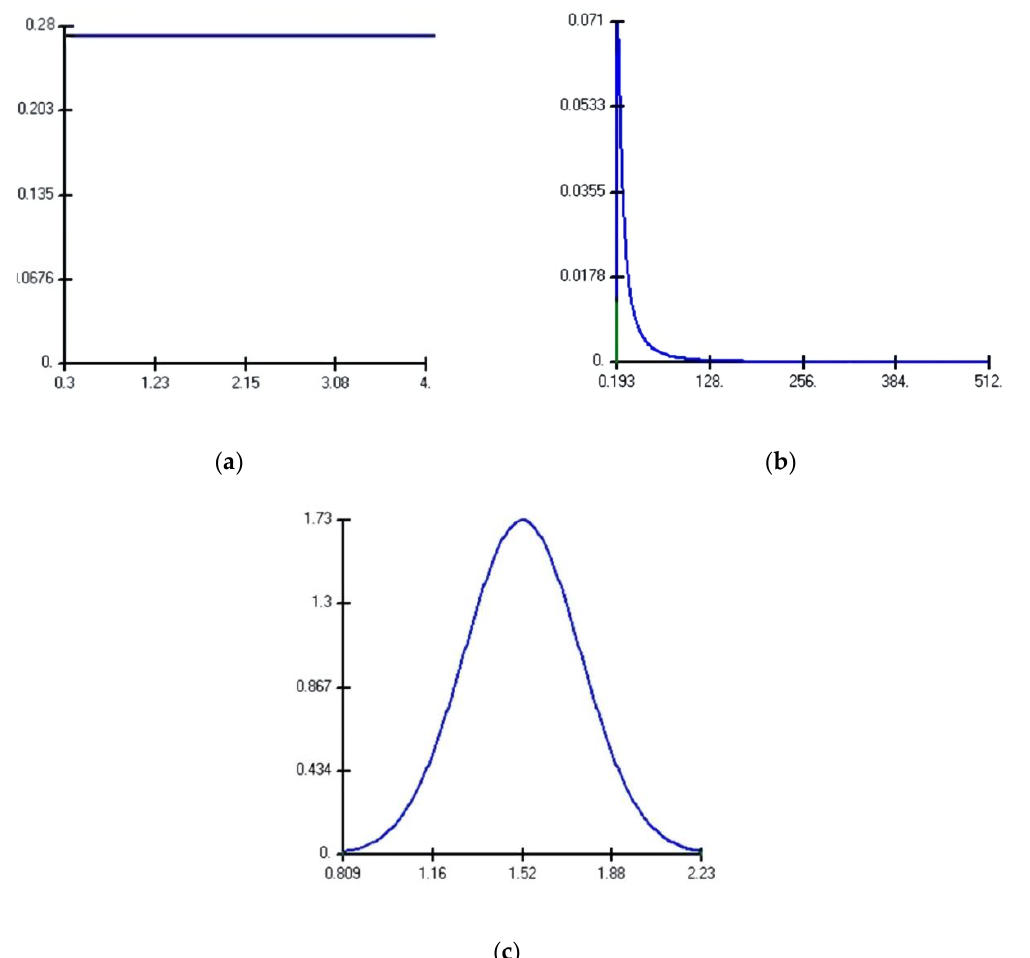
Figure 1. Assigned distribution type graph for priority 1 parameter: ( a ) uniform; ( b ) bounded lognormal; ( c ) truncated normal.